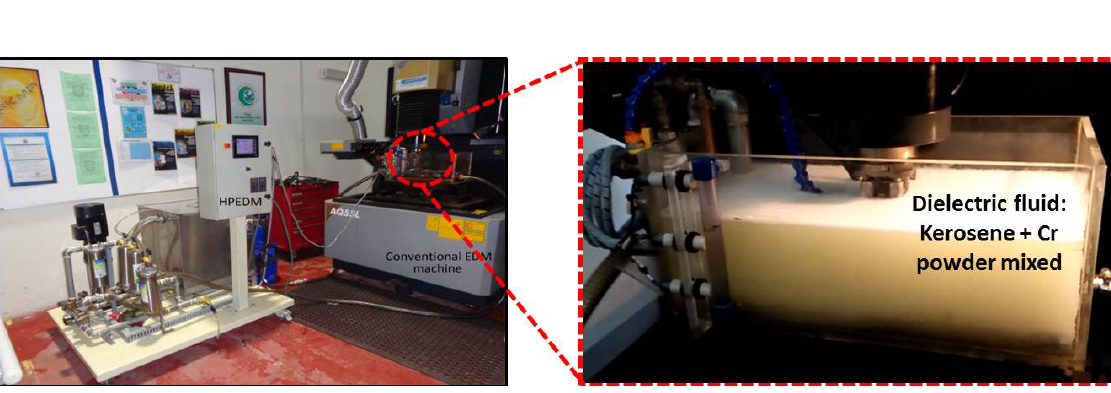
Figure 2: Chromium powder was suspended in the dielectric fluid